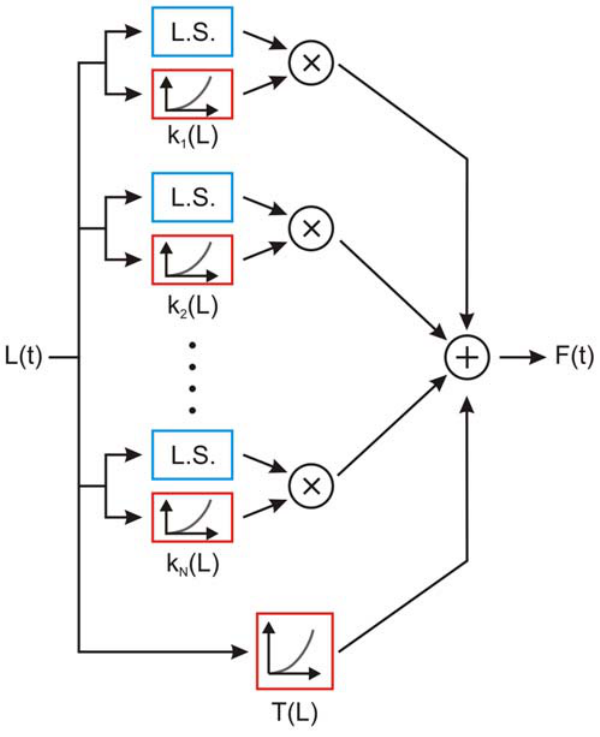
Figure 5. Schematic view of the adaptive QLV model (Eq. 17). Blue is used for linear processes, and red is used to indicate nonlinearities. Because the nonlinearity does not precede the linear stage (L.S.), superposition does not hold (unlike the QLV model, Fig. 1B).